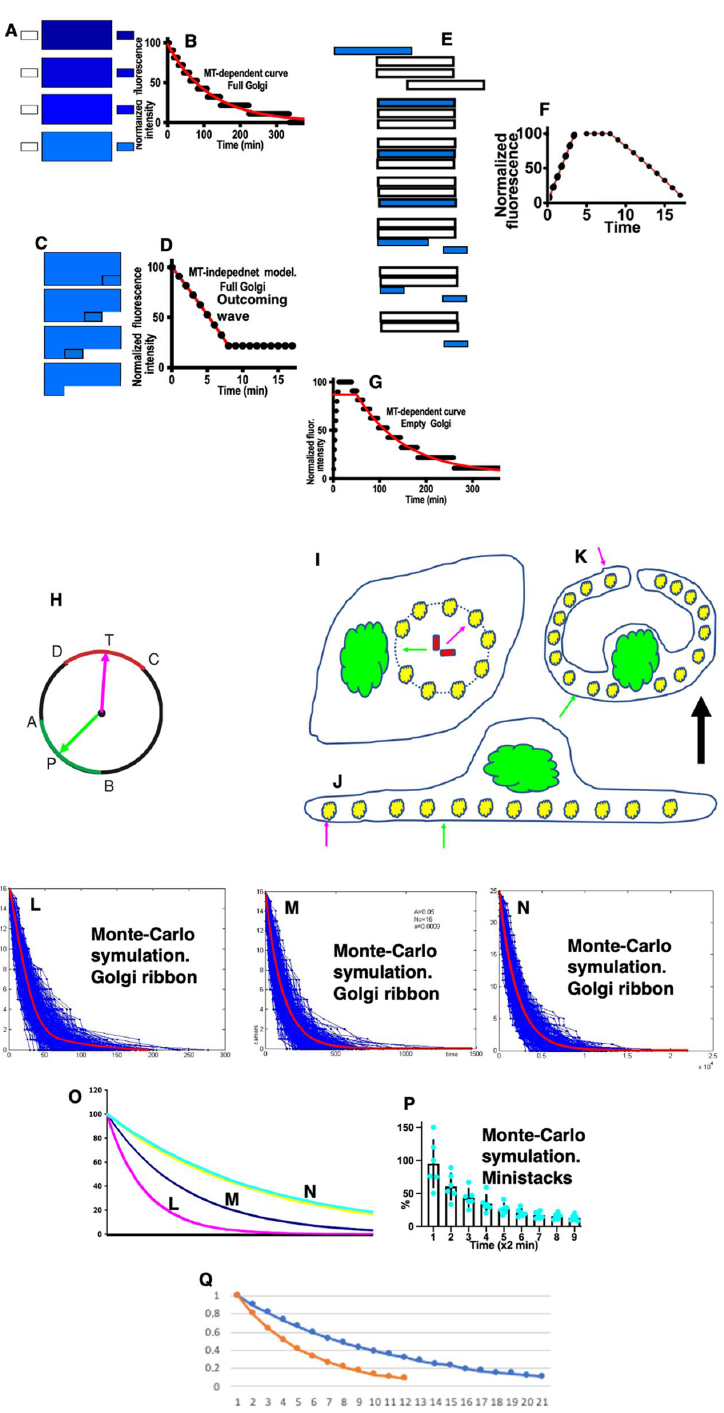
Figure 2. Schemes illustrating kinetics of IGT. The planels in ( A – G ) are explained in the text in detail. ( H ) Scheme of the dependency of the GPC departure on the microtubule growth (see Movies S4 and